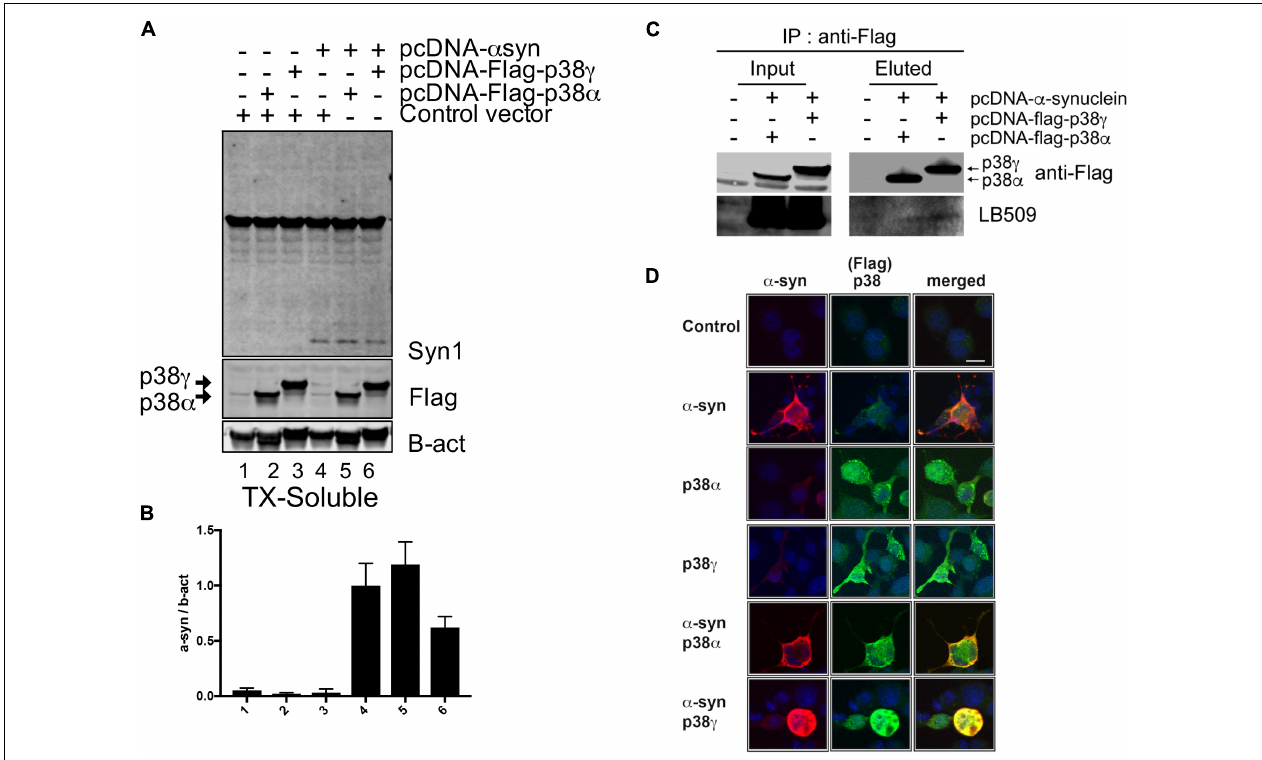
FIGURE 7 | Immunoprecipitation analysis between p38 and α -synuclein in a neuronal cell line. B103 neuroblastoma cells were transfected with pcDNA3, pcDNA-human- α -synuclein, pcDNA3-Flag-p38 α , and pcDNA3-Flag-p38 γ and analyzed by immunoblotting and immunocytochemistry. (A) After 48 h of transfection, cell lysates were analyzed by western blot and probed with an antibody against Flag to detect p38 α , p38 γ , and α -syn (Syn1); (B) levels of p38 α , p38 γ and α -syn were determined by densitometric quantification. (C) Co-immunoprecipitation of p38 α , p38 γ , and α -syn. p38 α and p38 γ were pulled down from transfected cell lysates and analyzed by western blot with an antibody against pathological α -syn (LB509) showing the interaction between α -syn and p38 γ . (D) Representative images from double immunostaining for α -syn (red)/p38 α (green) and α -syn (red)/p38 γ (green). Strong colocalization (yellow) was observed in neuronal cells co-expressing α -syn and p38 γ . Scale bar is 10 µ